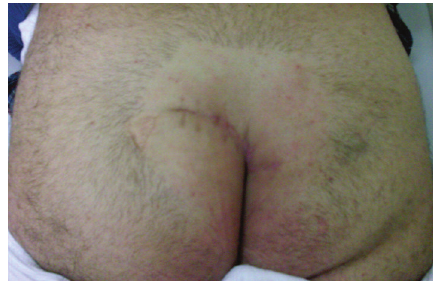
Figure 4: Postoperative appearance of the operative field at the end of one-year followup.